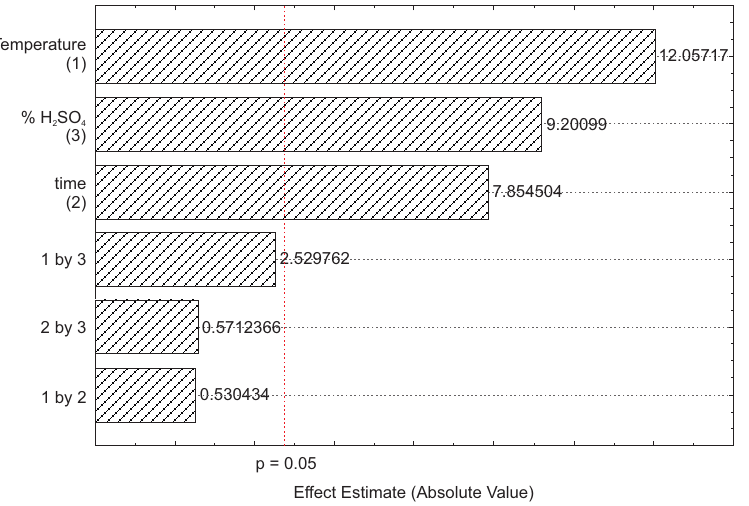
Figure 2. Pareto chart of standardized effects for X C adjustment with the greater